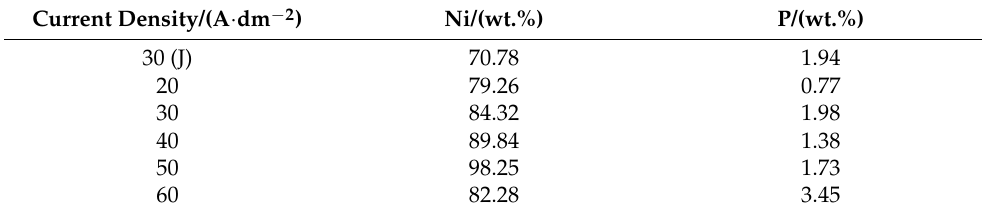
Table 3. The quality fraction of the surface elements of the